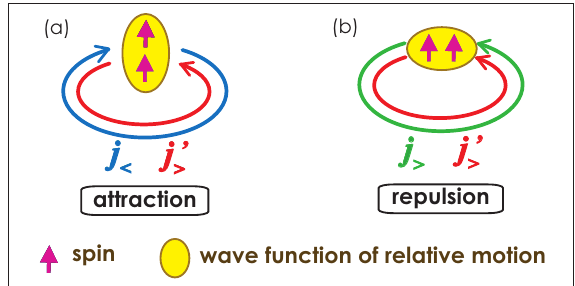
Figure 4. Monopole interaction of the tensor force for ( a ) between the orbits j < and j (cid:48) > , and ( b ) between the orbits j > and j (cid:48) > . See Equation (1) for the definitions of the orbits j > and j < . See text for more details. Taken from [23].